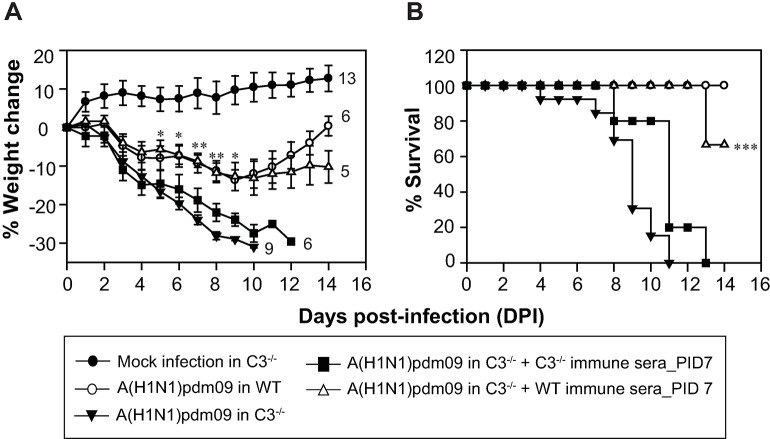
Antibodies generated during early phase of the infection are critical in containing the virus infection.C3-/- mice on C57BL/6 background, untreated or treated with immune sera (250μl each at day -1 and 6 post-infection), were infected intranasally with 450 TCID50 of the virus in PBS and monitored for body weight loss and survival for 14 days post-infection. A) Percentage of body weight loss during the infection in mice untreated or treated with the indicated sera. Body weight was normalized to their initial body weight. The number of animals utilized in each group is shown at the end of the line for that group. Statistical comparisons were performed between C3-/- immune sera treated and WT immune sera treated mice. Significant weight gain was observed in WT immune sera treated mice. *p < 0.05 and **p < 0.02. B) Percentage of survival during the infection in mice untreated or treated with the indicated sera. About 67% of the mice treated with WT immune sera recovered. C3-/- immune sera treated versus WT immune sera treated mice: ***p < 0.001.